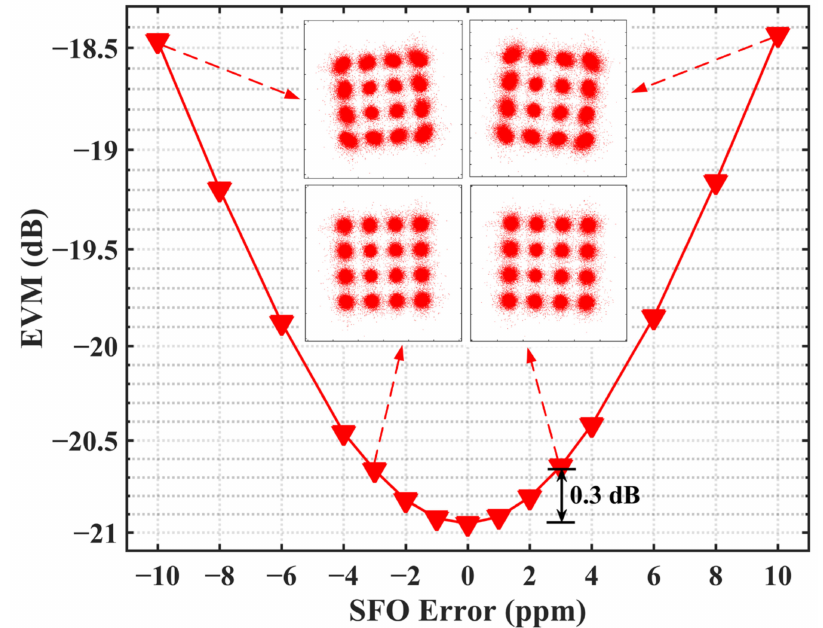
Figure 3. EVM performance versus SFO estimation